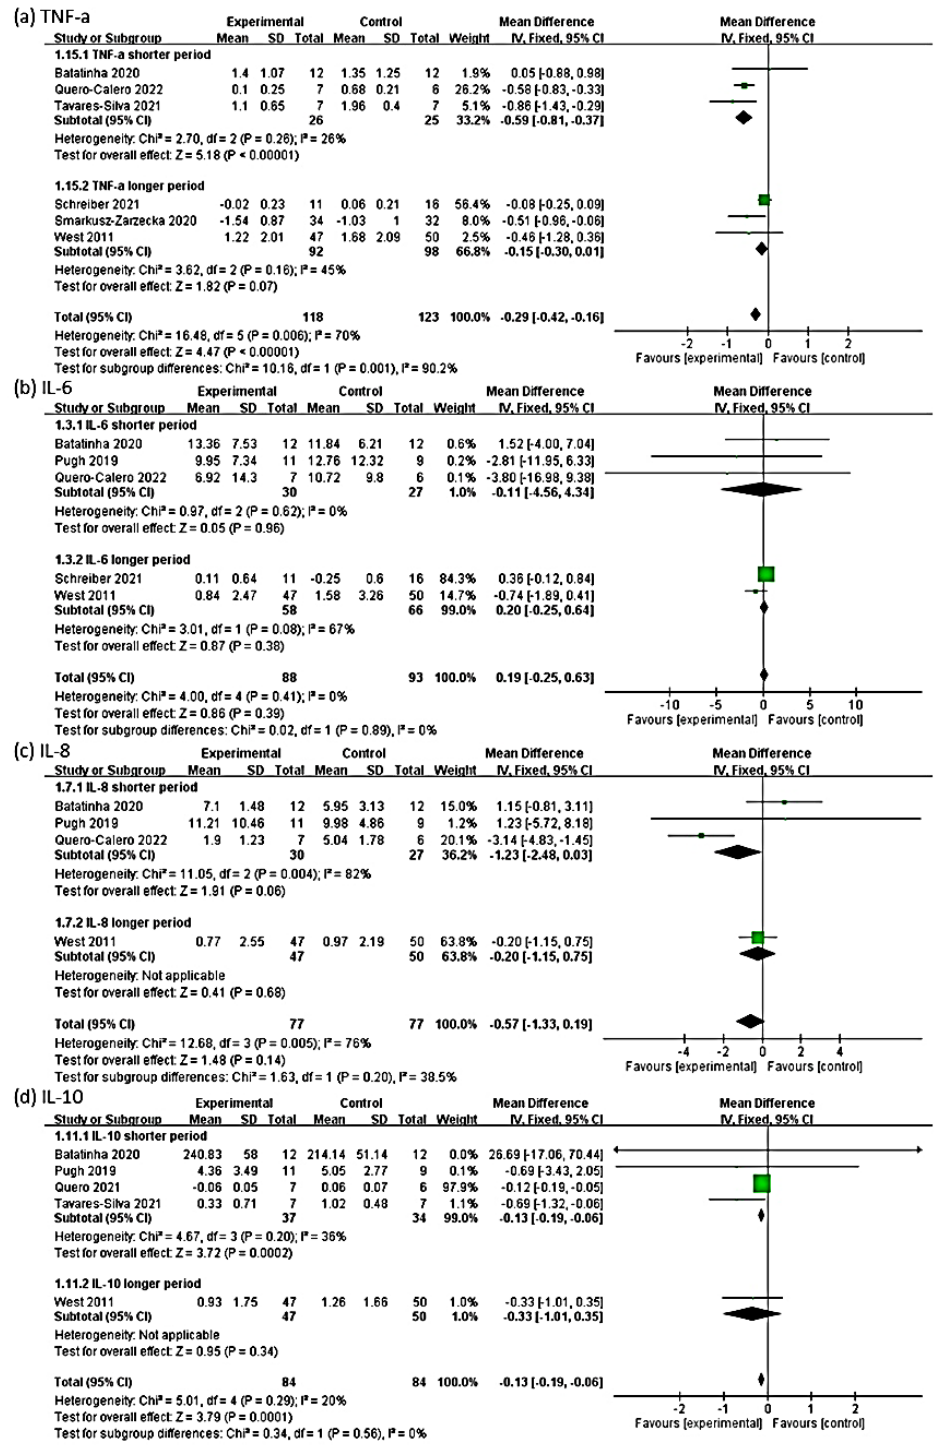
Figure 5. Forest plots of the mean effect size for the subgroups with a shorter and longer intervention period for ( a ) TNF −α, ( b ) IL − 6, ( c ) IL − 8, and ( d ) IL − 10.